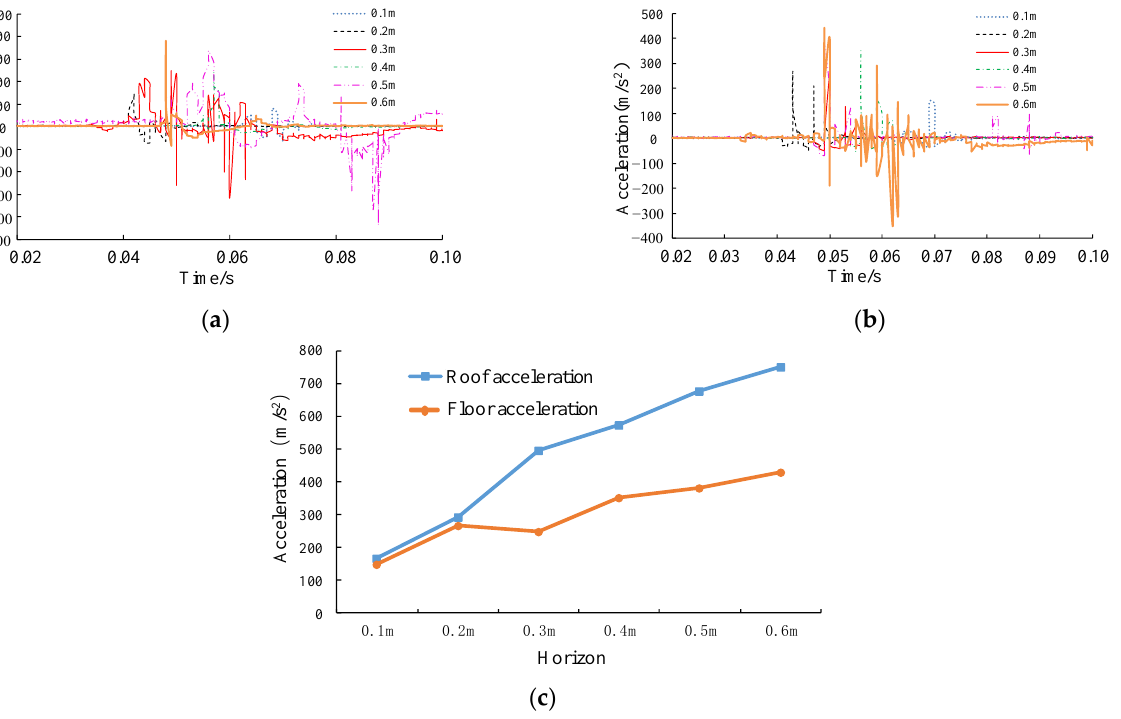
Figure 14. Acceleration response characteristics of coal and rock in the seventh layered test. ( a ) Acceleration at the roof of surrounding rock; ( b ) Acceleration at the floor of the roadway; ( c ) Peak acceleration at different energies.